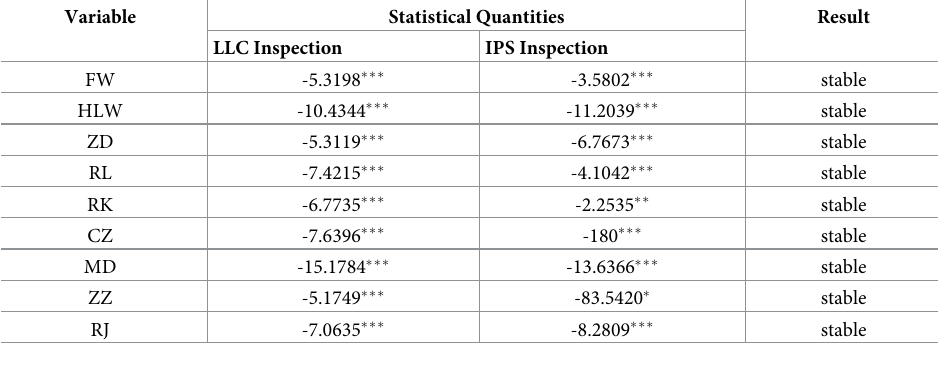
Table 4. Unit root test results for each